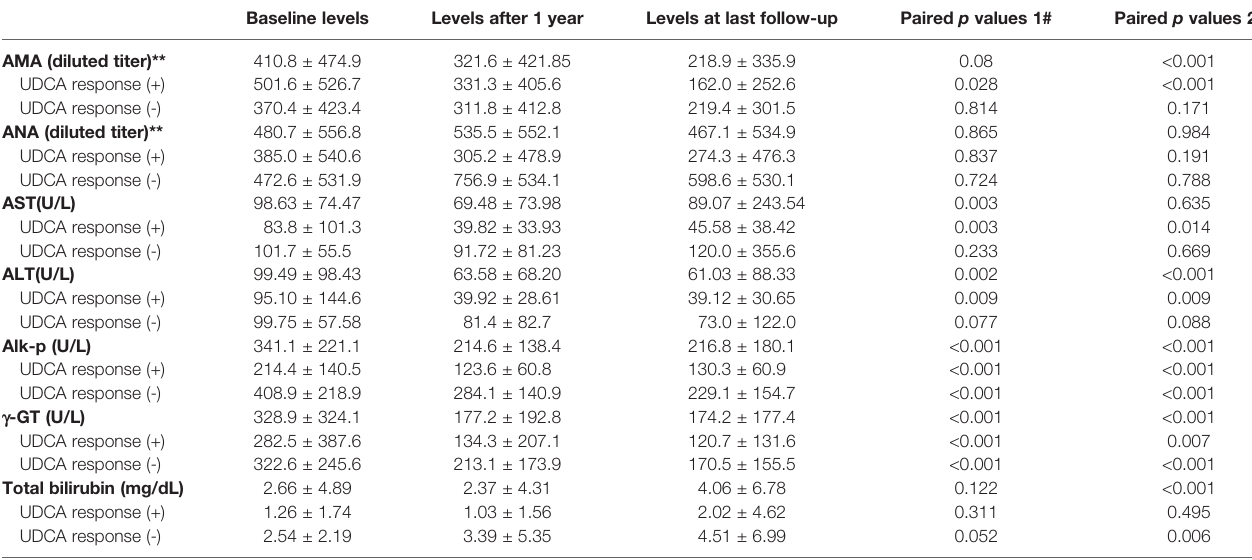
TABLE 3 | Longitudinal alterations of biochemistry of the PBC patients. Baseline levels Levels after 1 year Levels at last follow-up Paired p values 1# Paired p values